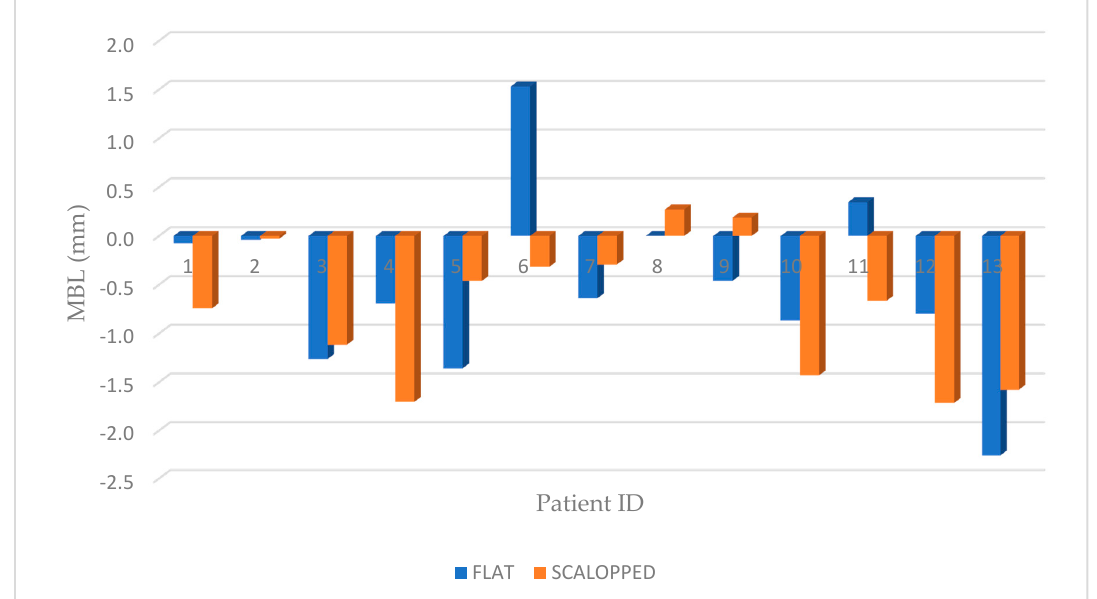
Figure 5. Graphic representation of MBL of both groups, for each patient, at T1 where no statistically significant difference was shown between the test (scalloped) and control (flat) groups (P = 0.333).